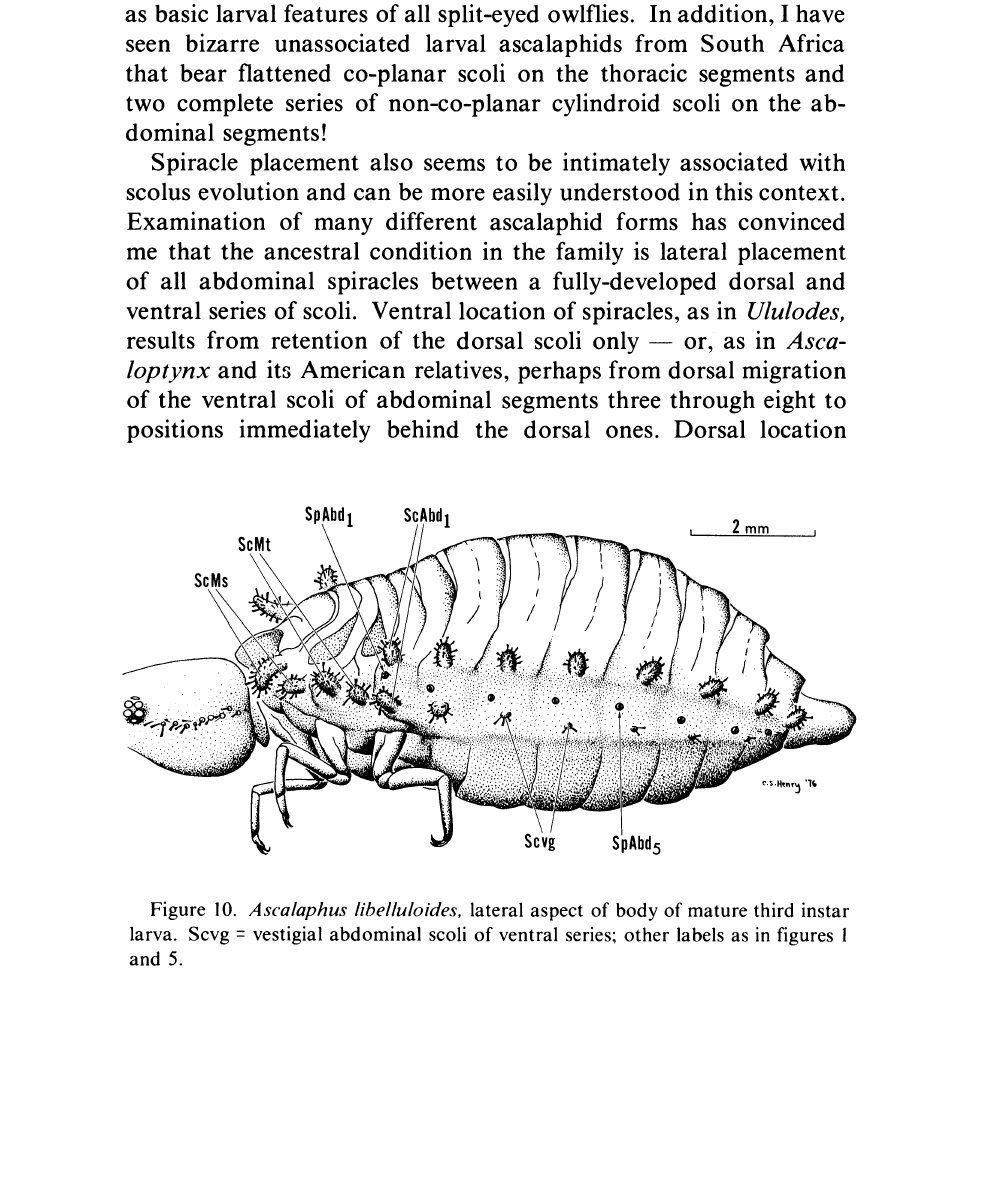
Figure 10. Ascalaphus libelluloides, lateral aspect of body of mature third instar larva. Scvg vestigial abdominal scoli of ventral series; other labels as in figures and